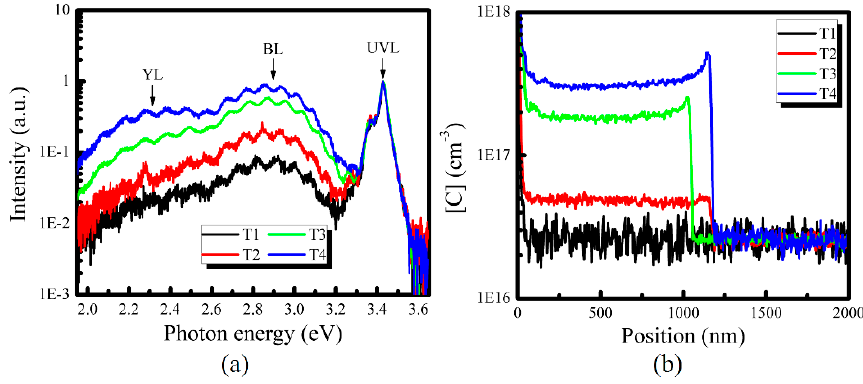
Figure 4. ( a ) Room-temperature PL spectra of u-GaN samples T1–T4 grown under different temperature, and ( b ) the carbon distribution profile. The arrows indicate the main luminescence bands.